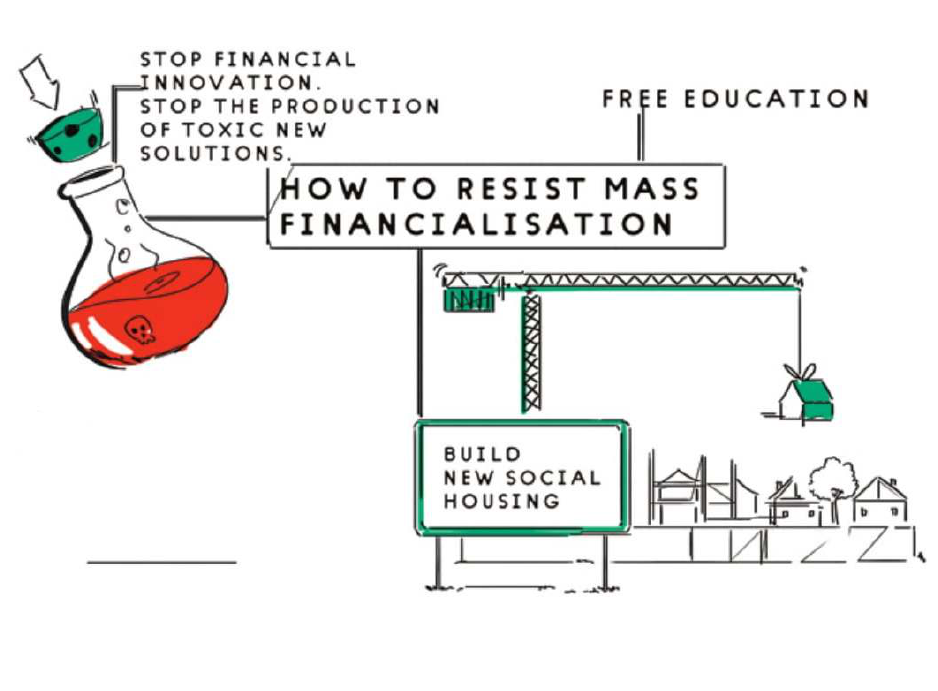
Figure 6. Resistance to Elite Financialisation